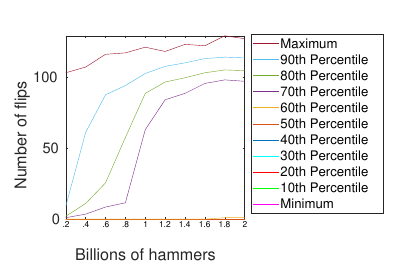
Figure 4: Distributions of total flips after 200 million to 2 billion hammers on PAC.